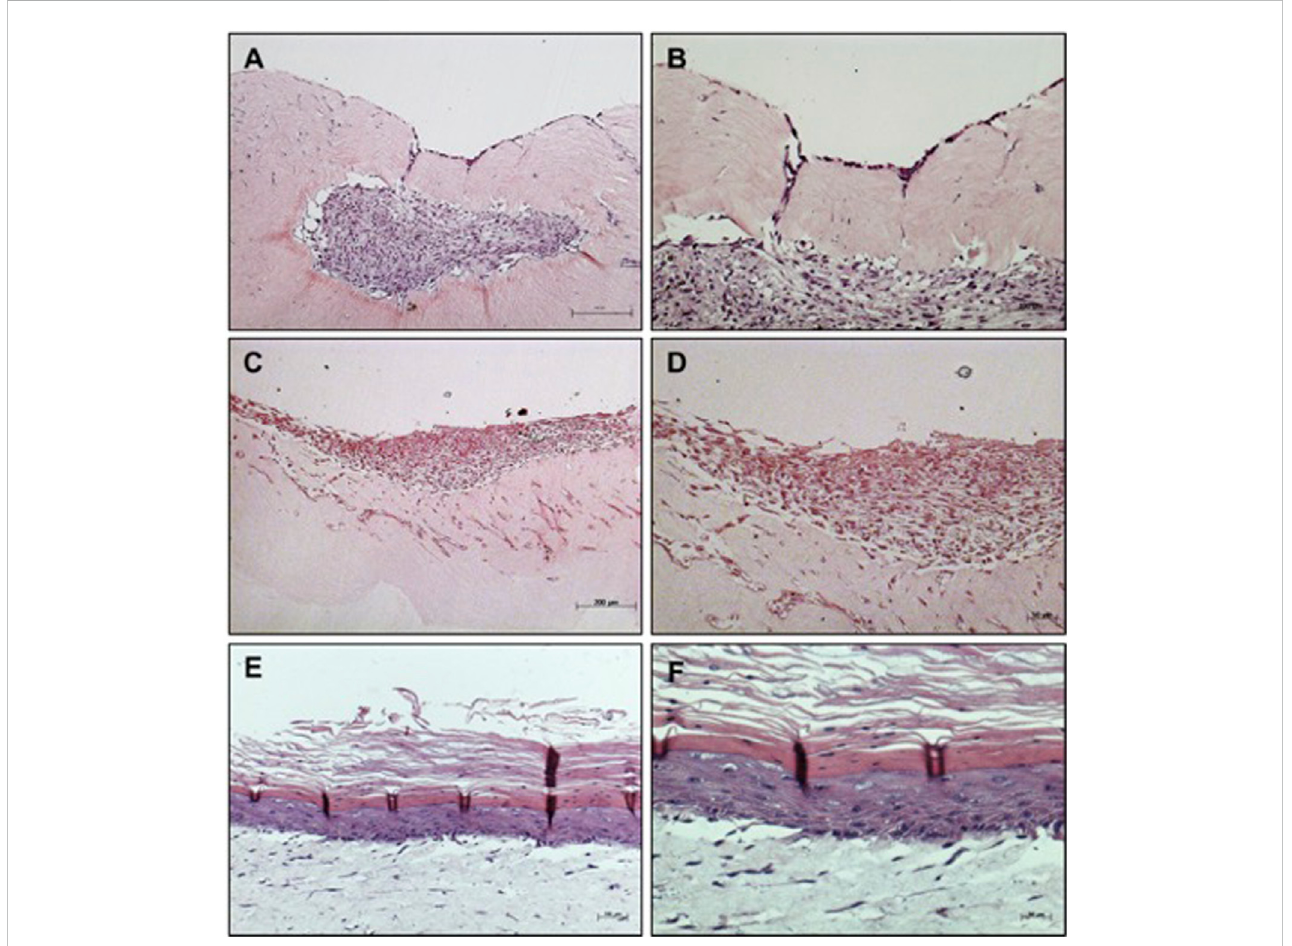
FIGURE 2 Organotypic cultures using MatriXpec ™ as dermal equivalent. (A,B) MSC cultured with LD10 or (C,D) MSC cultured with KGM/DM (E,F) Basal keratinocytes cultured with KGM/DM were used as positive control for the strati fi ed epidermis using MatriXpec. After 1 day of immersion in the indicated medium in each case, cultures were exposed to ALI for 10 days in (A,B) LD10 medium or KGM/DM (C – F) . Hematoxylin-eosin staining. Magni fi cation of ×100 (A, C, and E) and 200x (B, D, and F)